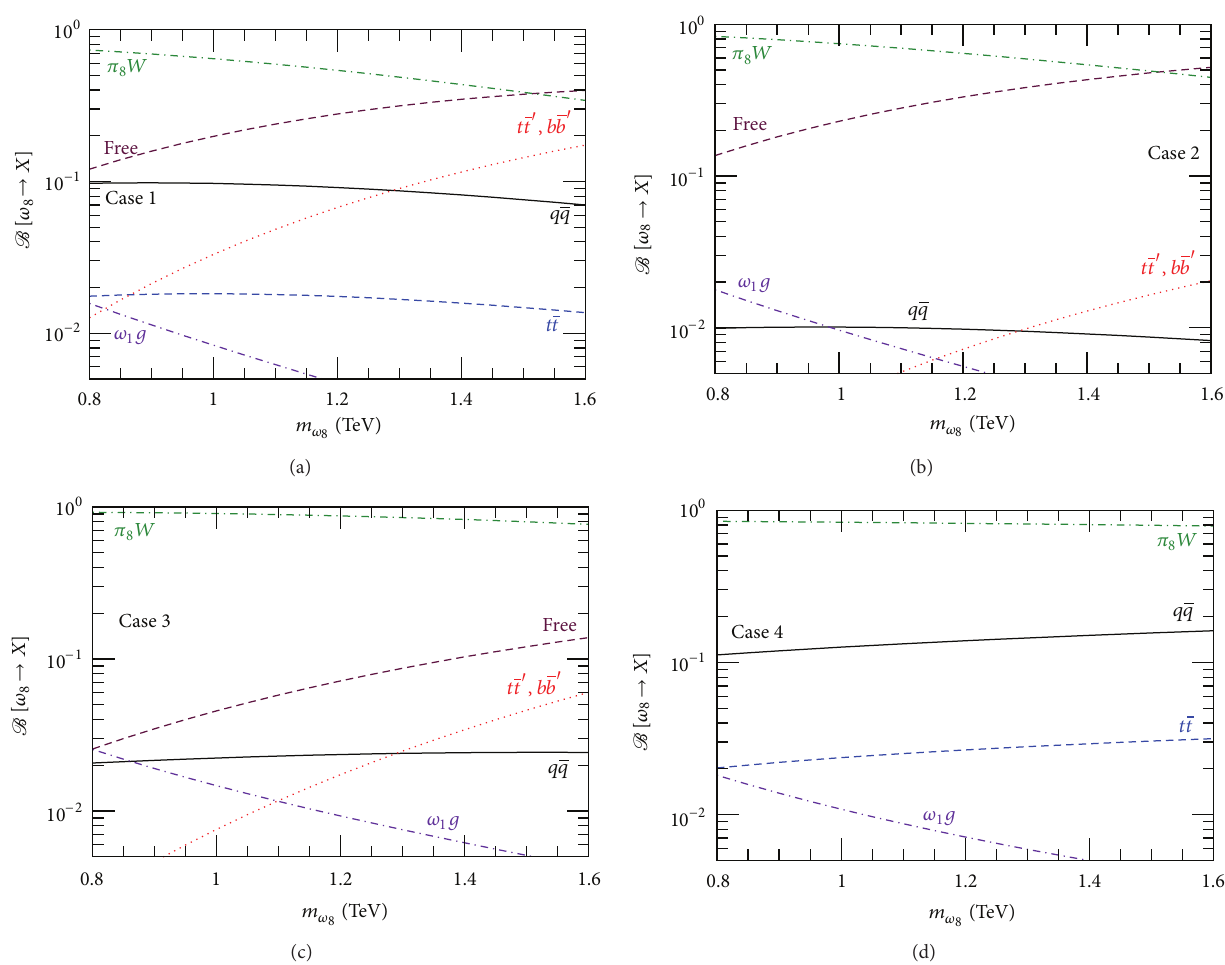
Figure 10: Branching ratio of 𝜔 8 as a function of 𝑚 𝜔